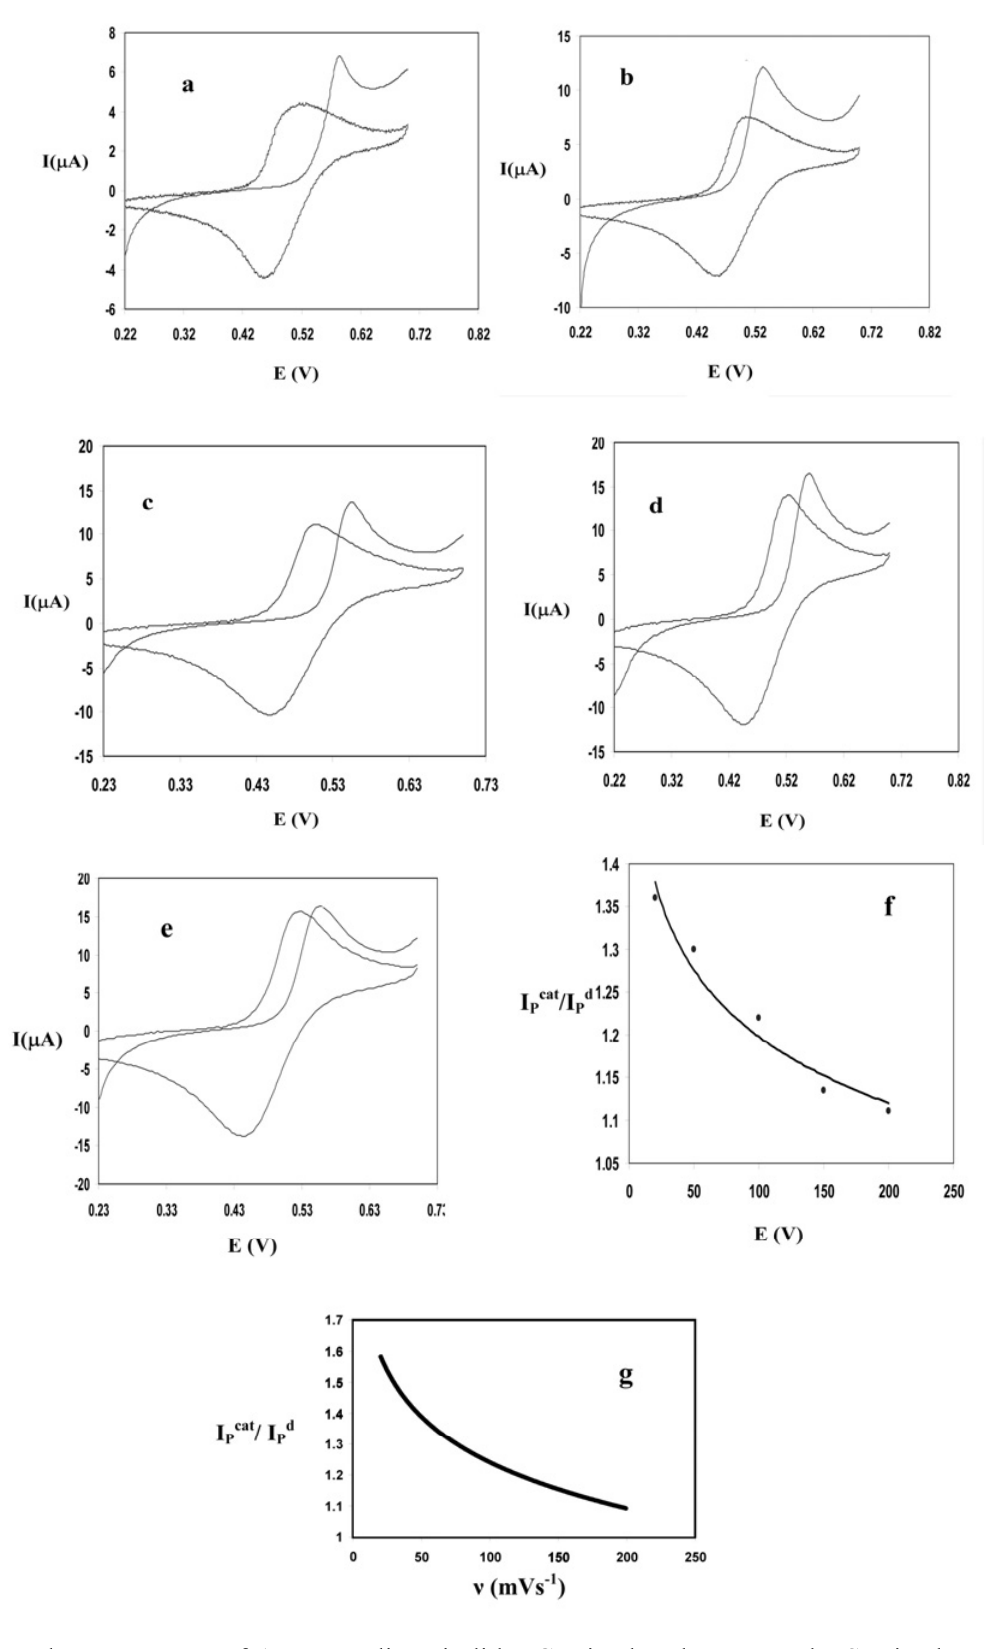
Figure 5. Voltammograms of 1 mM sodium iodide, CV in the absence and LSV in the presence of 2 mM phenol at GC electrode, at various scan rates. Scan rates from (a) to (e) are: 20, 50, 100, 150, and 200 mV s -1 , respectively. Curves f and g show the variation peak of the current ratio ( I pcat /I pd ) as a function of scan rate for phenol and